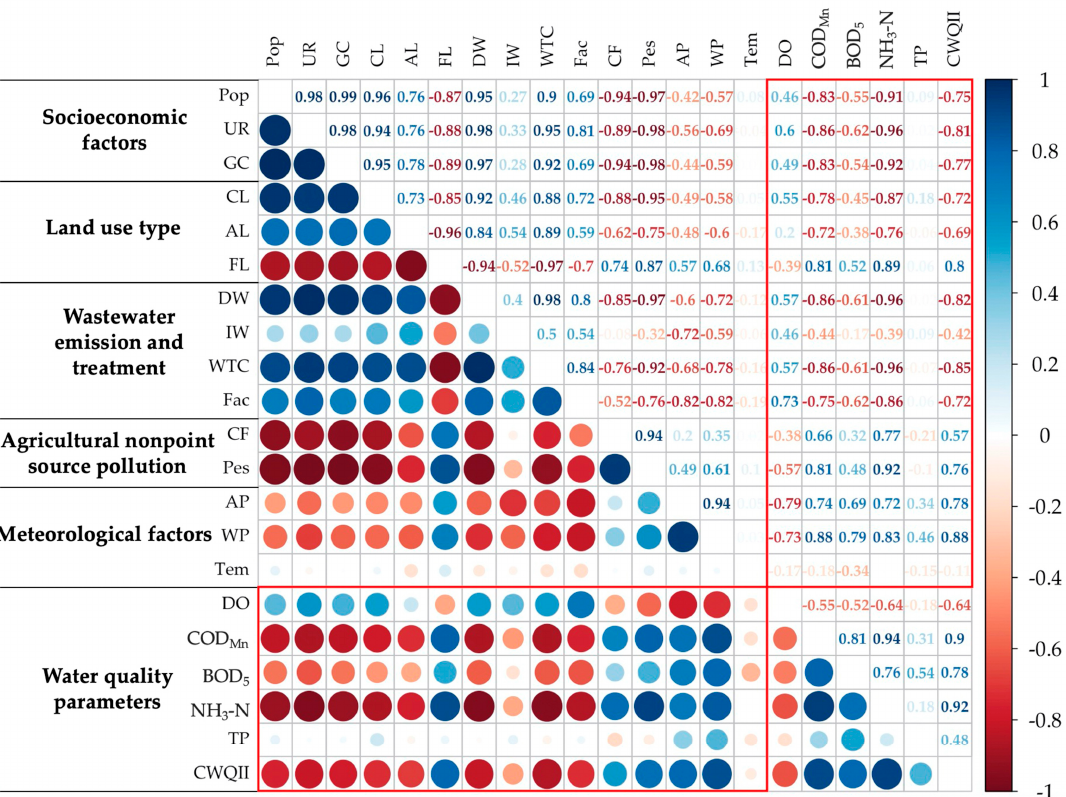
Figure 8. Pearson correlation coefficients of water quality parameters and their influencing factors in Xuzhou section. The full names of indicators are as follows: Pop–population; UR–urbanization rate; GC–GDP per capita; CL–construction land area; AL–agricultural land area; FL–forest land